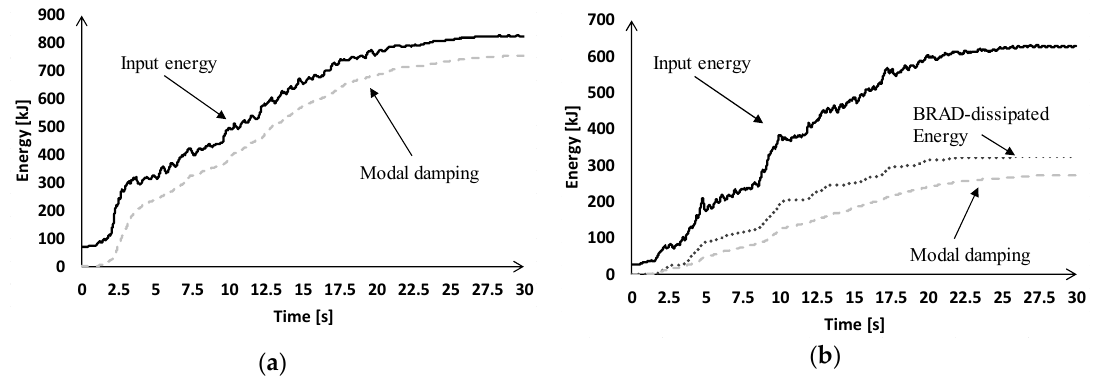
Figure 9. Energy diagrams for building A in: ( a ) as-built configuration; ( b ) after retrofit.